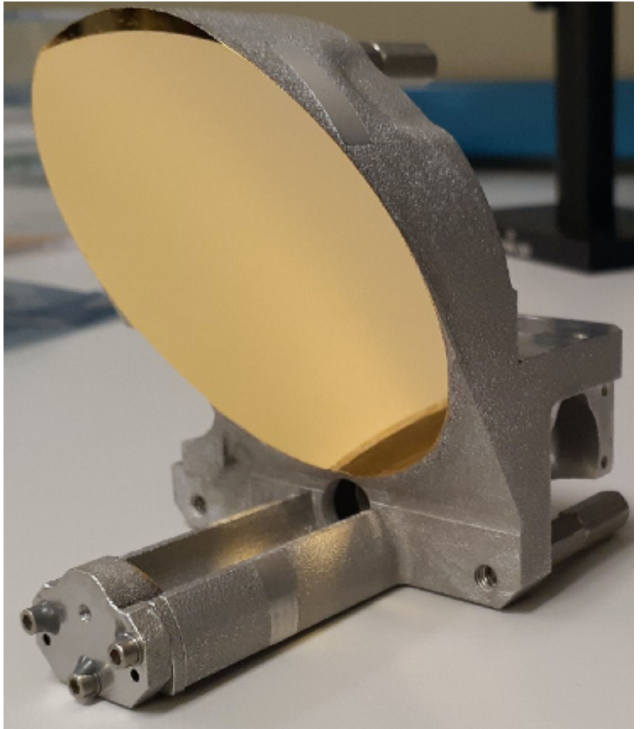
Figure 4. Photograph of the SALi receiver telescope. It features an afocal off-axis Cassegrain reflector with a clear aperture of 6.4 cm diameter and 8 times